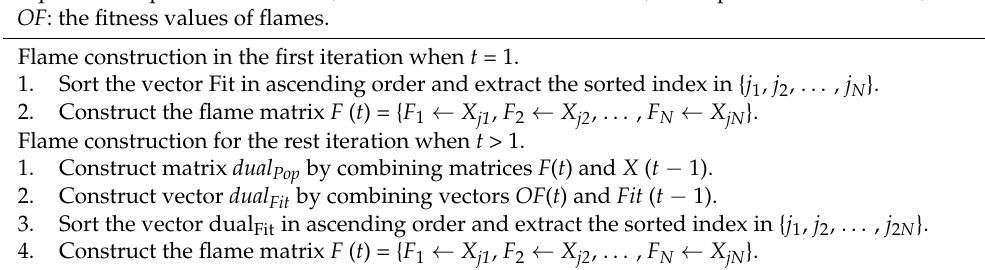
Table 1. Flame construction